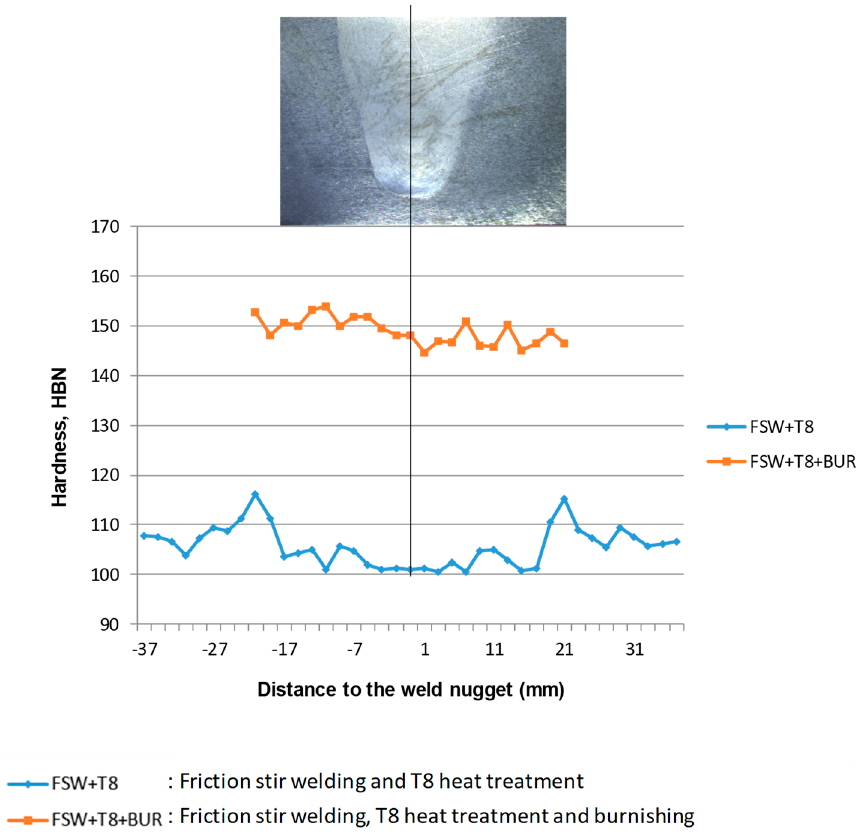
Figure 7. Effect of burnishing in Brinell hardness of the surface across the weld line.